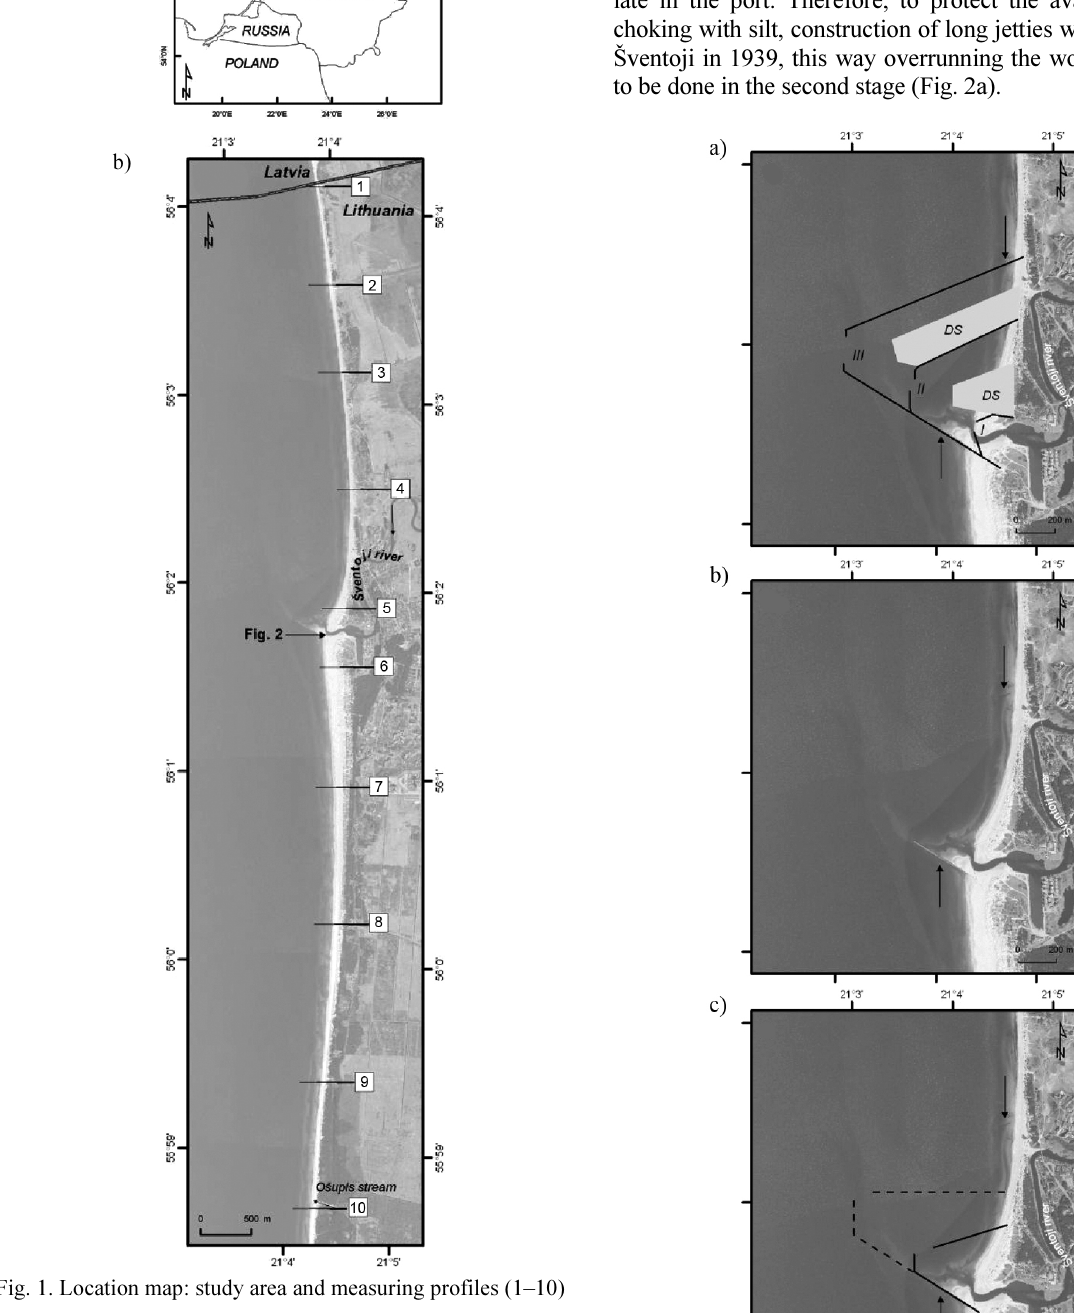
Fig. 1. Location map: study area and measuring profiles (1–10) At the time, three stages of Šventoji port construc- tion and development were planned (Fig. 2a).